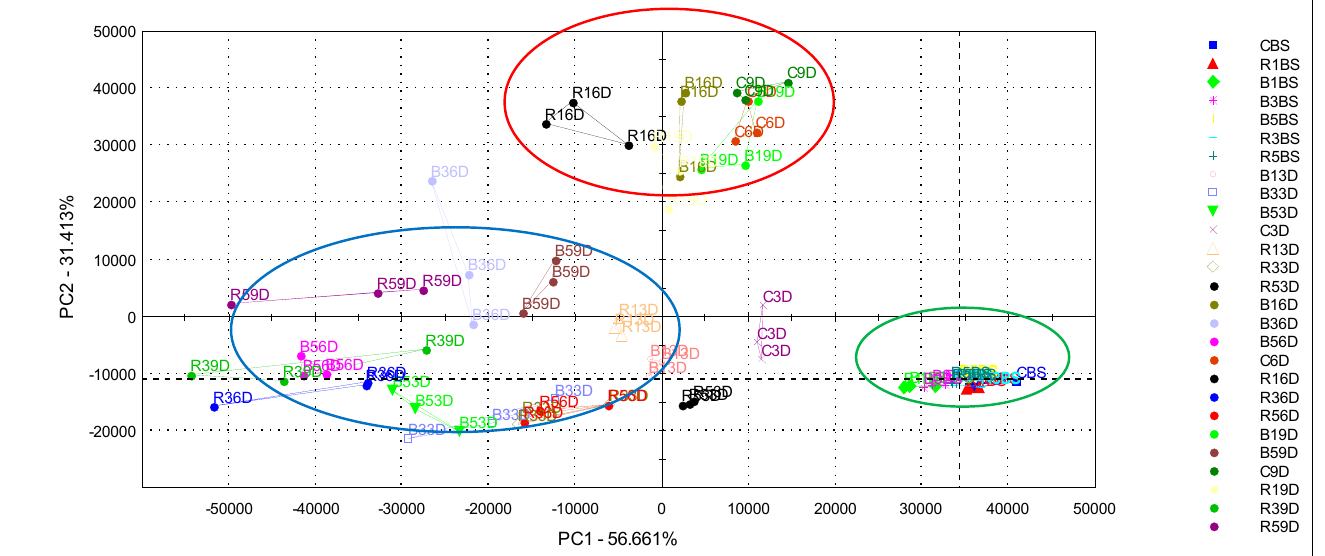
Figure 6. Principal component analysis (PCA) for volatile compounds of meat patties with different berries pomace additives stored for nine days (CBS—meat patties without additives before storage; C3D, C6D, C9D—without additives stored for 3, 6, 9 days; R1BS, B1BS, R3BS, B3BS, R5BS, B5BS—meat patties with 1, 3 and 5% of pomace additives before storage; R13D, B13D, R16D, B16D, R19D, B19D—with 1% of raspberry and blackberry pomace additives after 3, 6, 9 days of storage; R33D, B33D, R36D, B36D, R39D, B39D—with 3% of raspberry and blackberry pomace additives after 3, 6, 9 days of storage; R53D, B53D, R56D, B56D, R59D, B59D—with 5% of raspberry and blackberry pomace additives after 3, 6, 9 days of